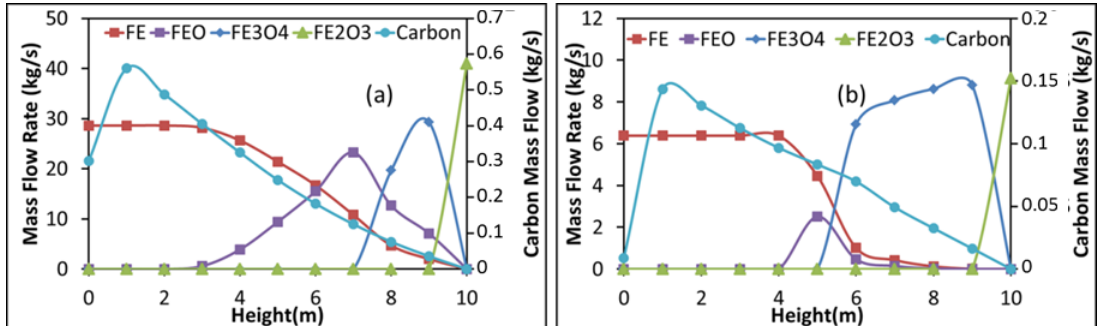
Figure 5. Evolution of the solid component flow rates with shaft height in Zone 1, ( a ) Contrecoeur; ( b ) Gilmore.